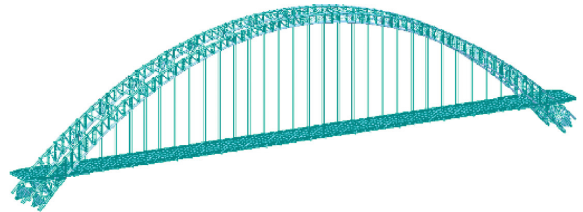
Figure 3: Established finite element